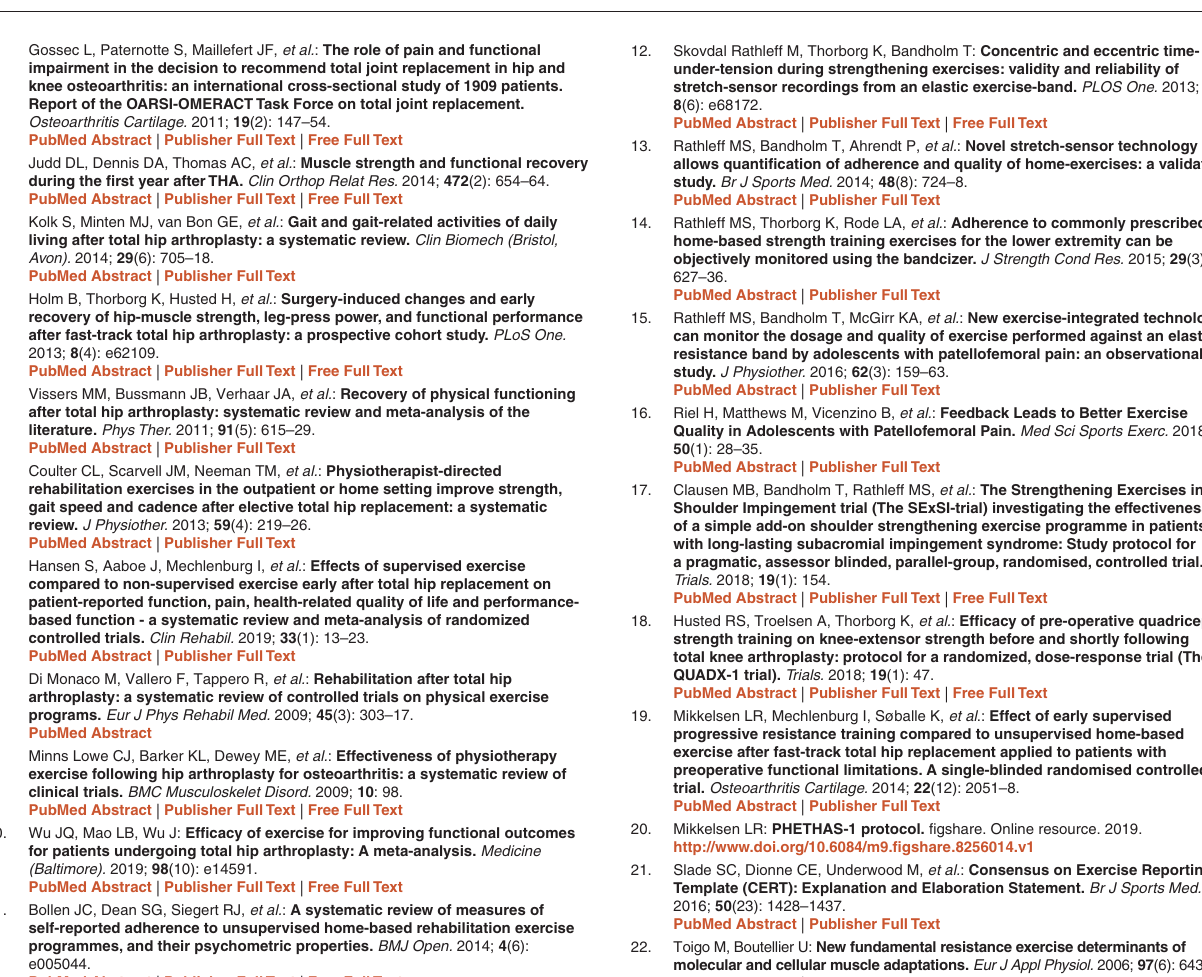
Figshare: SPIRIT checklist for “Pragmatic Home-Based Exercise after Total Hip Arthroplasty - Silkeborg: Protocol for a prospective cohort study (PHETHAS-1)”.